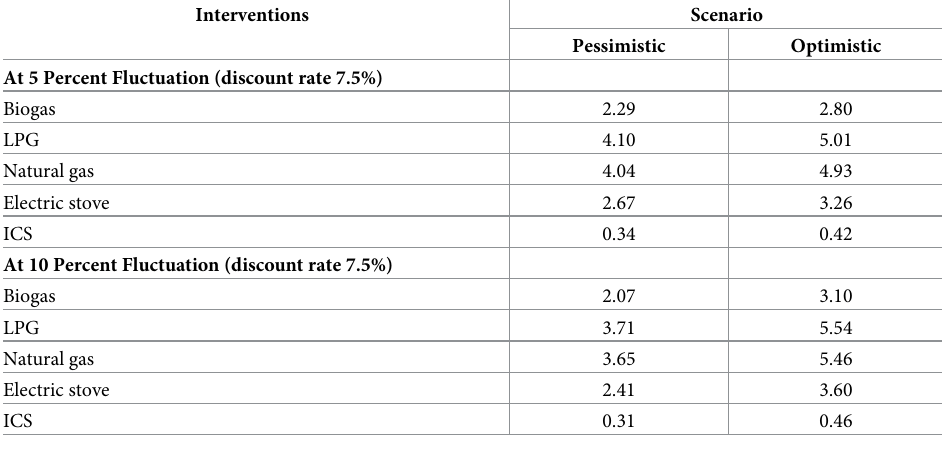
Table 5. BCRs for pessimistic and optimistic